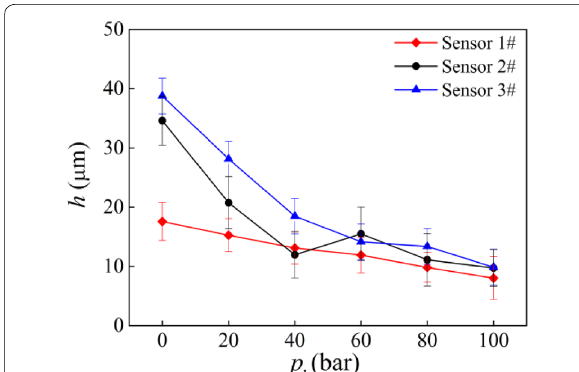
Figure 8 Change of the oil film thickness with pressure at high pressure region